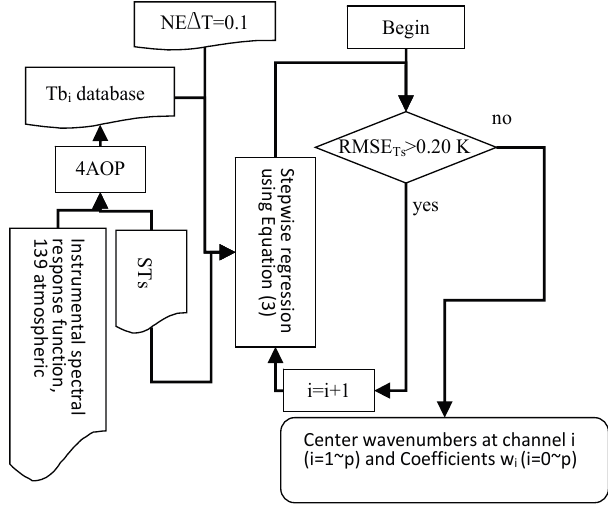
Figure 2. The scheme for determining the centre wavenumbers of channel i ( i = [1,p]) and the coefficients w i ( i =